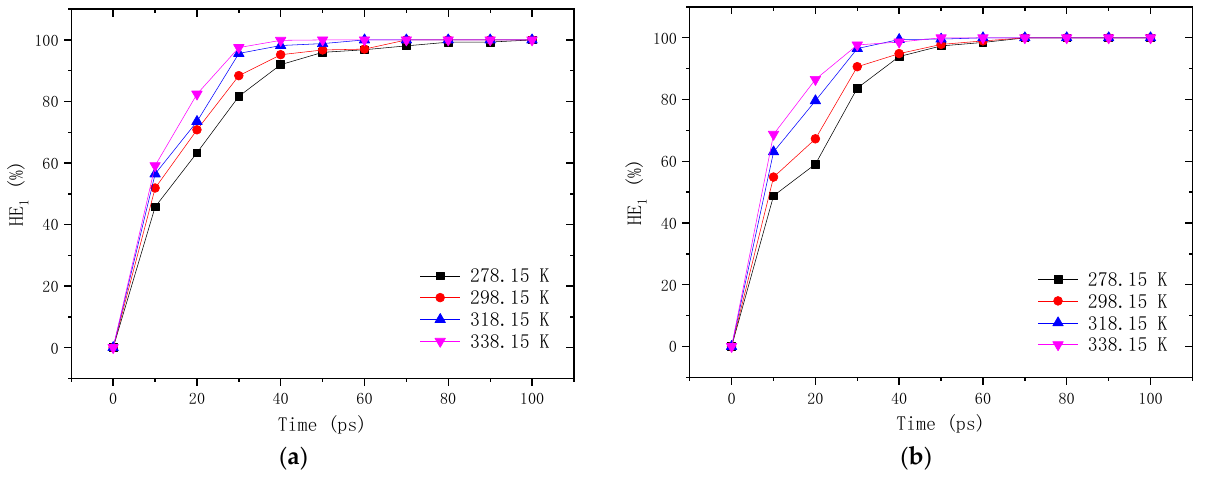
Figure 12. Self-healing efficiency of asphalt binder with 1 nm crack at different temperatures: ( a ) neat asphalt binder; ( b ) aged asphalt binder.